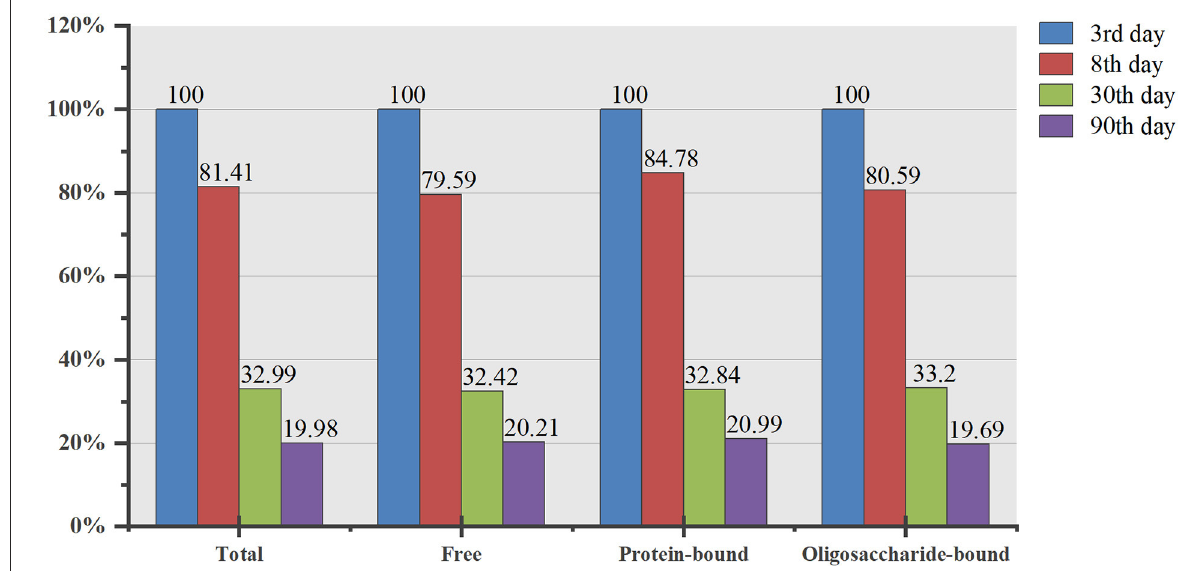
FIGURE2 Variation trend of total and each fraction of sialic acid compared with colostrum. The results are expressed as percentage (%); n = 33.